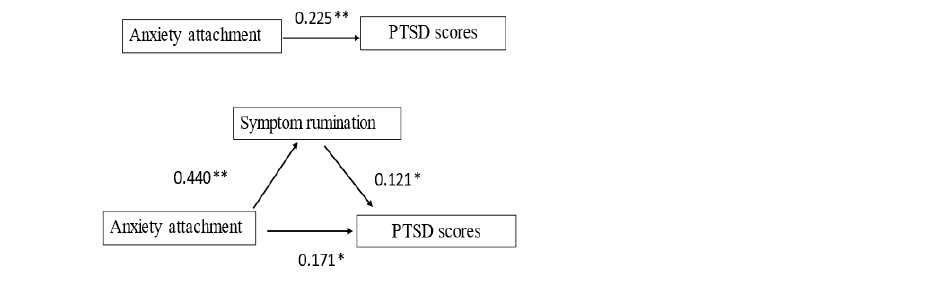
Figure 2. The mediating effect of symptom rumination on attachment anxiety and PTSD scores. ** p < 0.01, * p < 0.05. ** p < 0.01, * p <